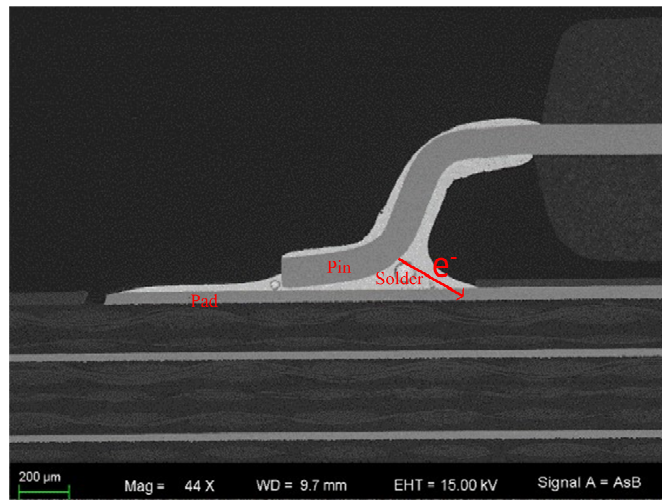
Figure 3. An SEM image of a QFP.